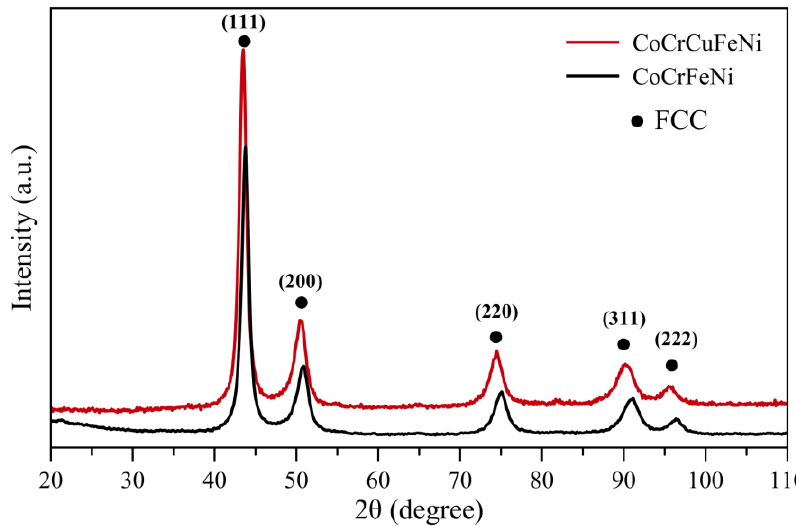
Figure 1. XRD patterns of MA CoCrFeNi and CoCrCuFeNi powder mixtures.